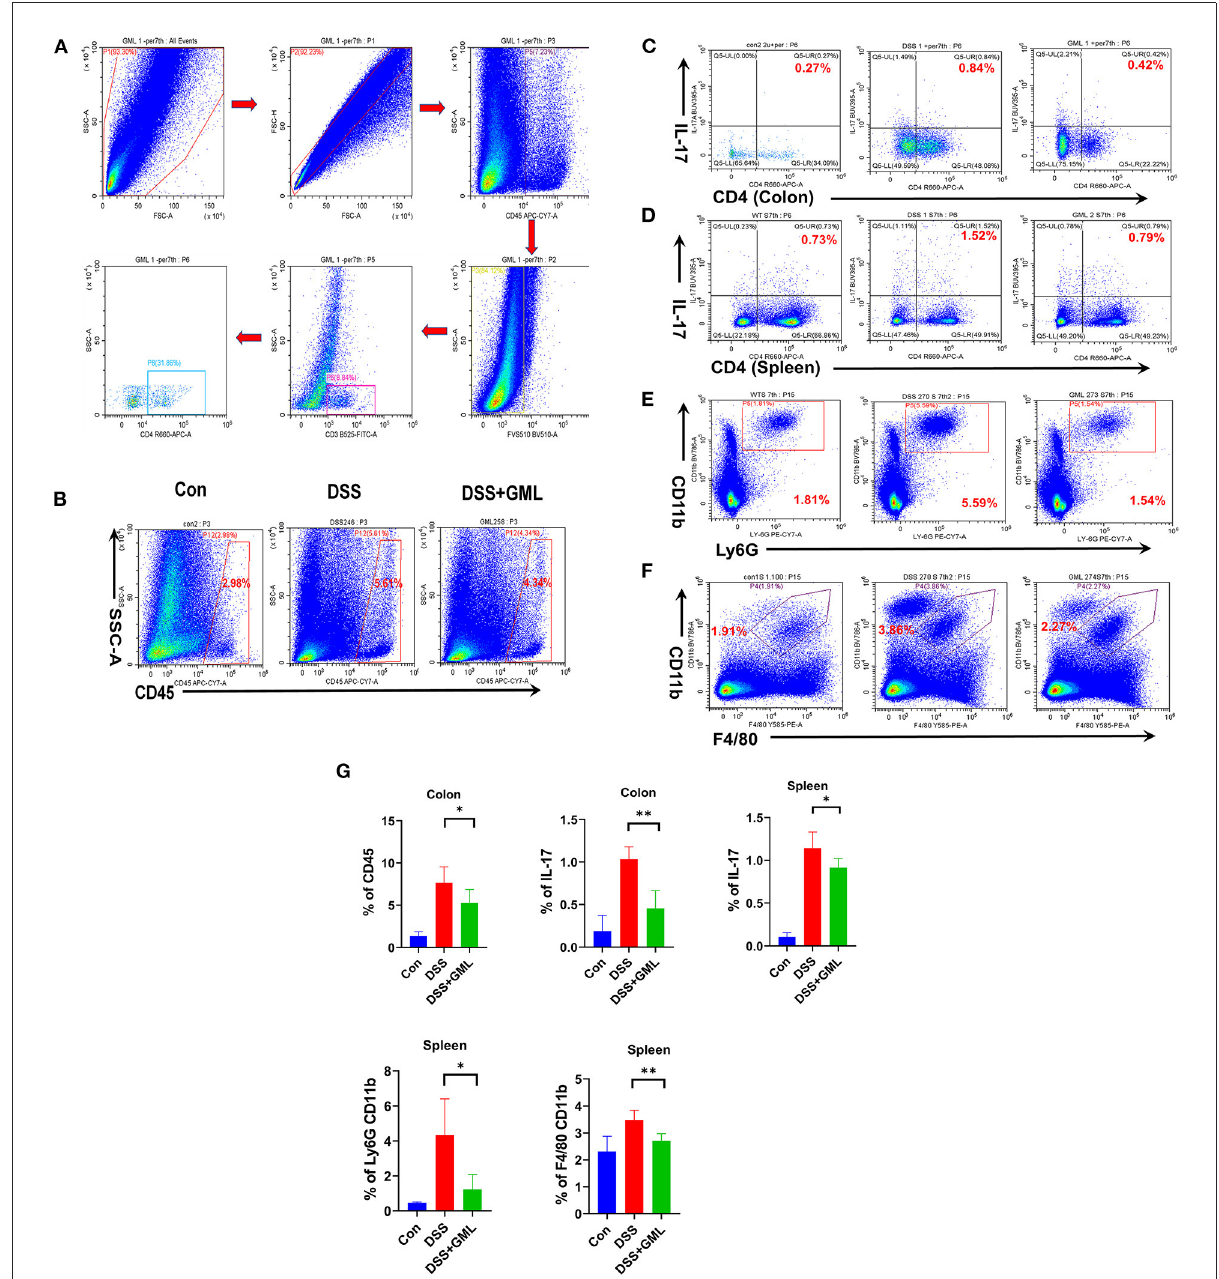
FIGURE4 GML could ameliorates DSS-induced acute colitis by inhibiting infiltration of Th17, neutrophils, macrophages. (A) Gating strategy for flow cytometric analysis. (B,C) CD45 and Th17 cells from LPMCs were detected by flow cytometry. (D–F) Th17 cells, macrophages and neutrophils in the spleen were detected by flow cytometry. (G) The results were computed and graphed by graphPad. The data are expressed as the means ± SDs ( n = 5). * P < 0.05; ** P < 0.01.